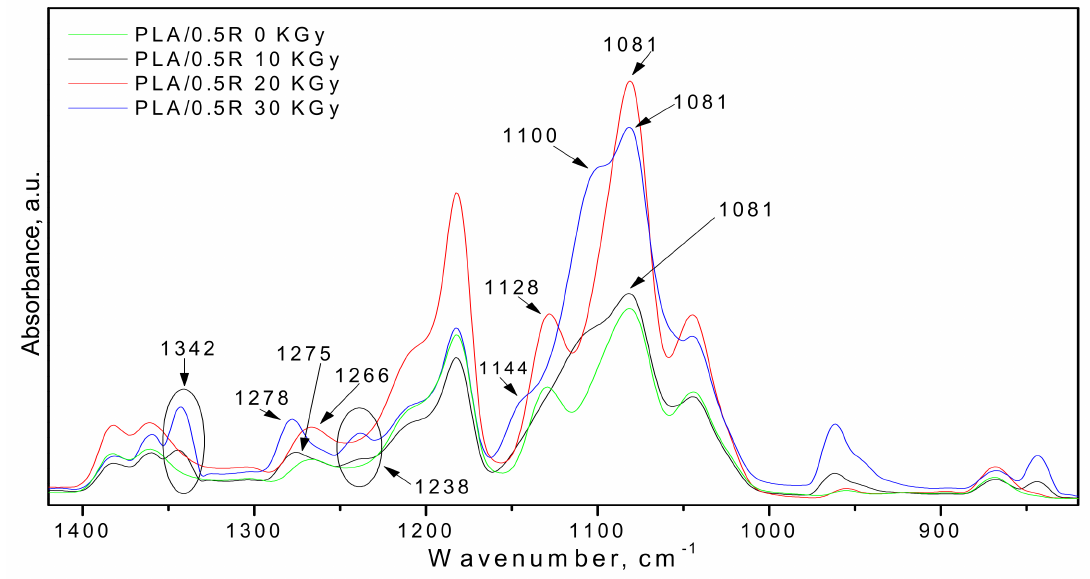
Figure 3. FT-IR spectra of PLA/0.5R blend at three different gamma irradiation doses (10, 20, and 30 kGy) in comparison with the non-irradiated